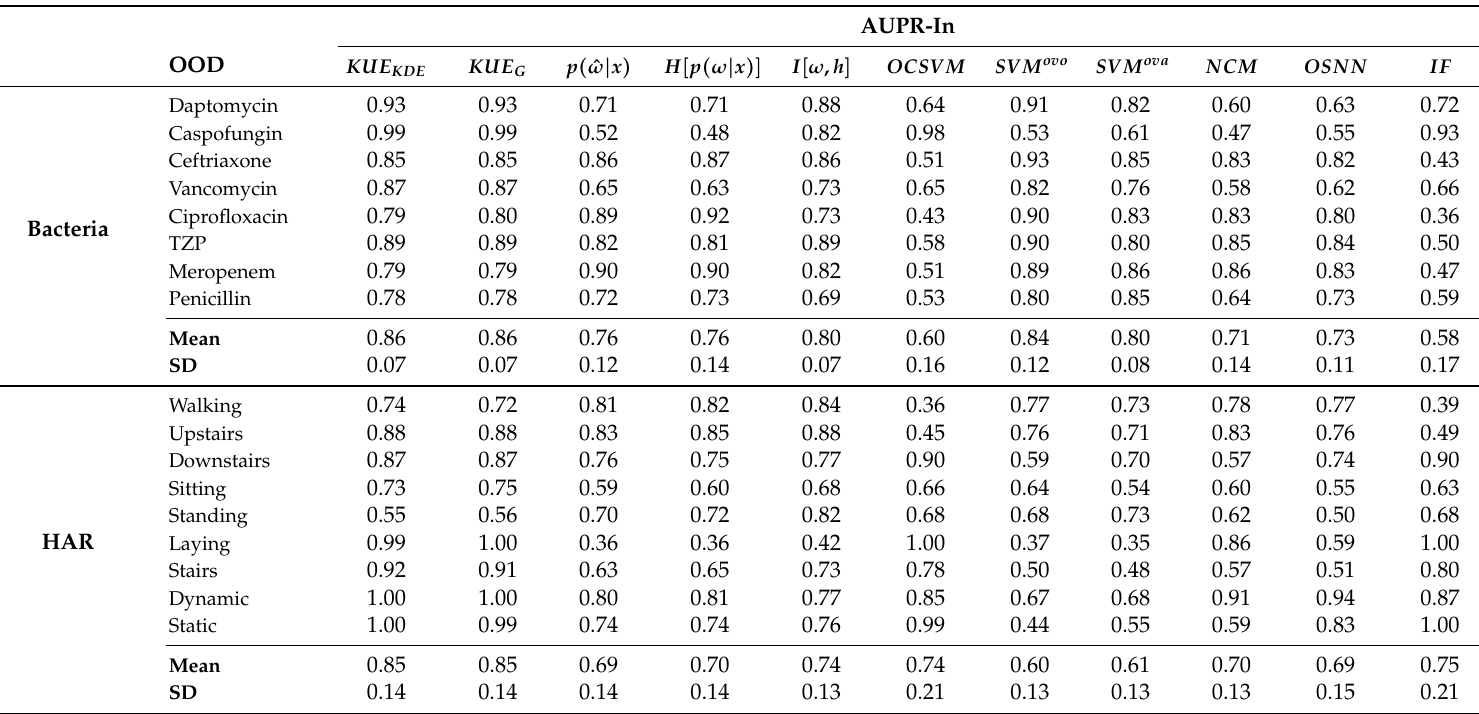
Table A4. AUPR-In for detecting OOD test inputs using two variants of KUE (KDE and Gaussian) and other baseline methods on 4 datasets. The Mean and Standard Deviation (SD) over OOD combinations is presented after each dataset. All values are averages over 10 consecutive